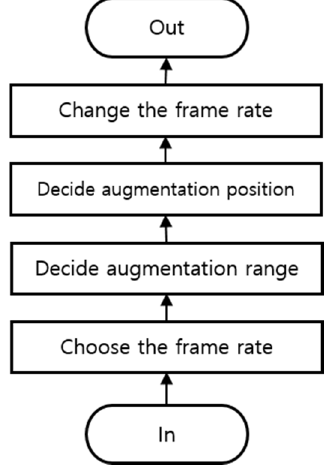
Figure 3. Flow chart of the proposed method.